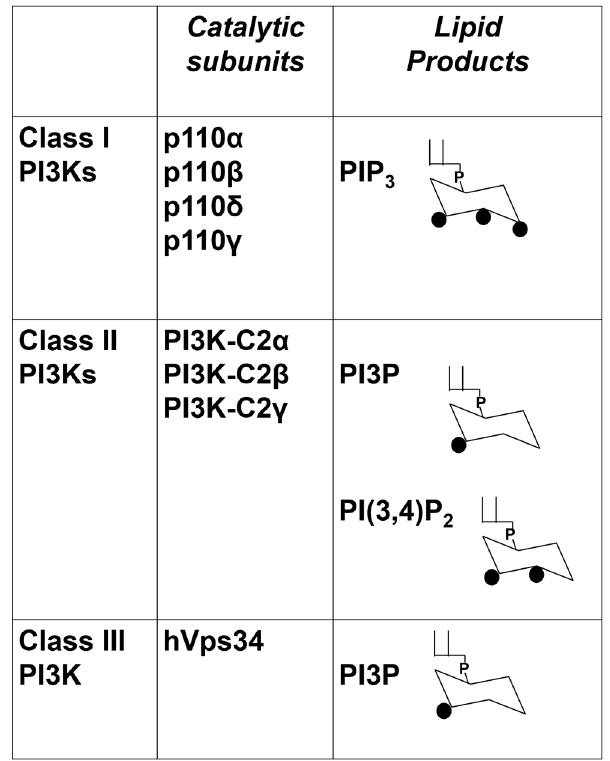
Figure 2. List of the eight mammalian PI3K isoforms and their classification into three distinct classes. For class I PI3Ks only the four catalytic subunits are shown. Their main lipid products are also indicated. Expression of the class I PI3K catalytic subunits p110 α and p110 β was detected in mouse